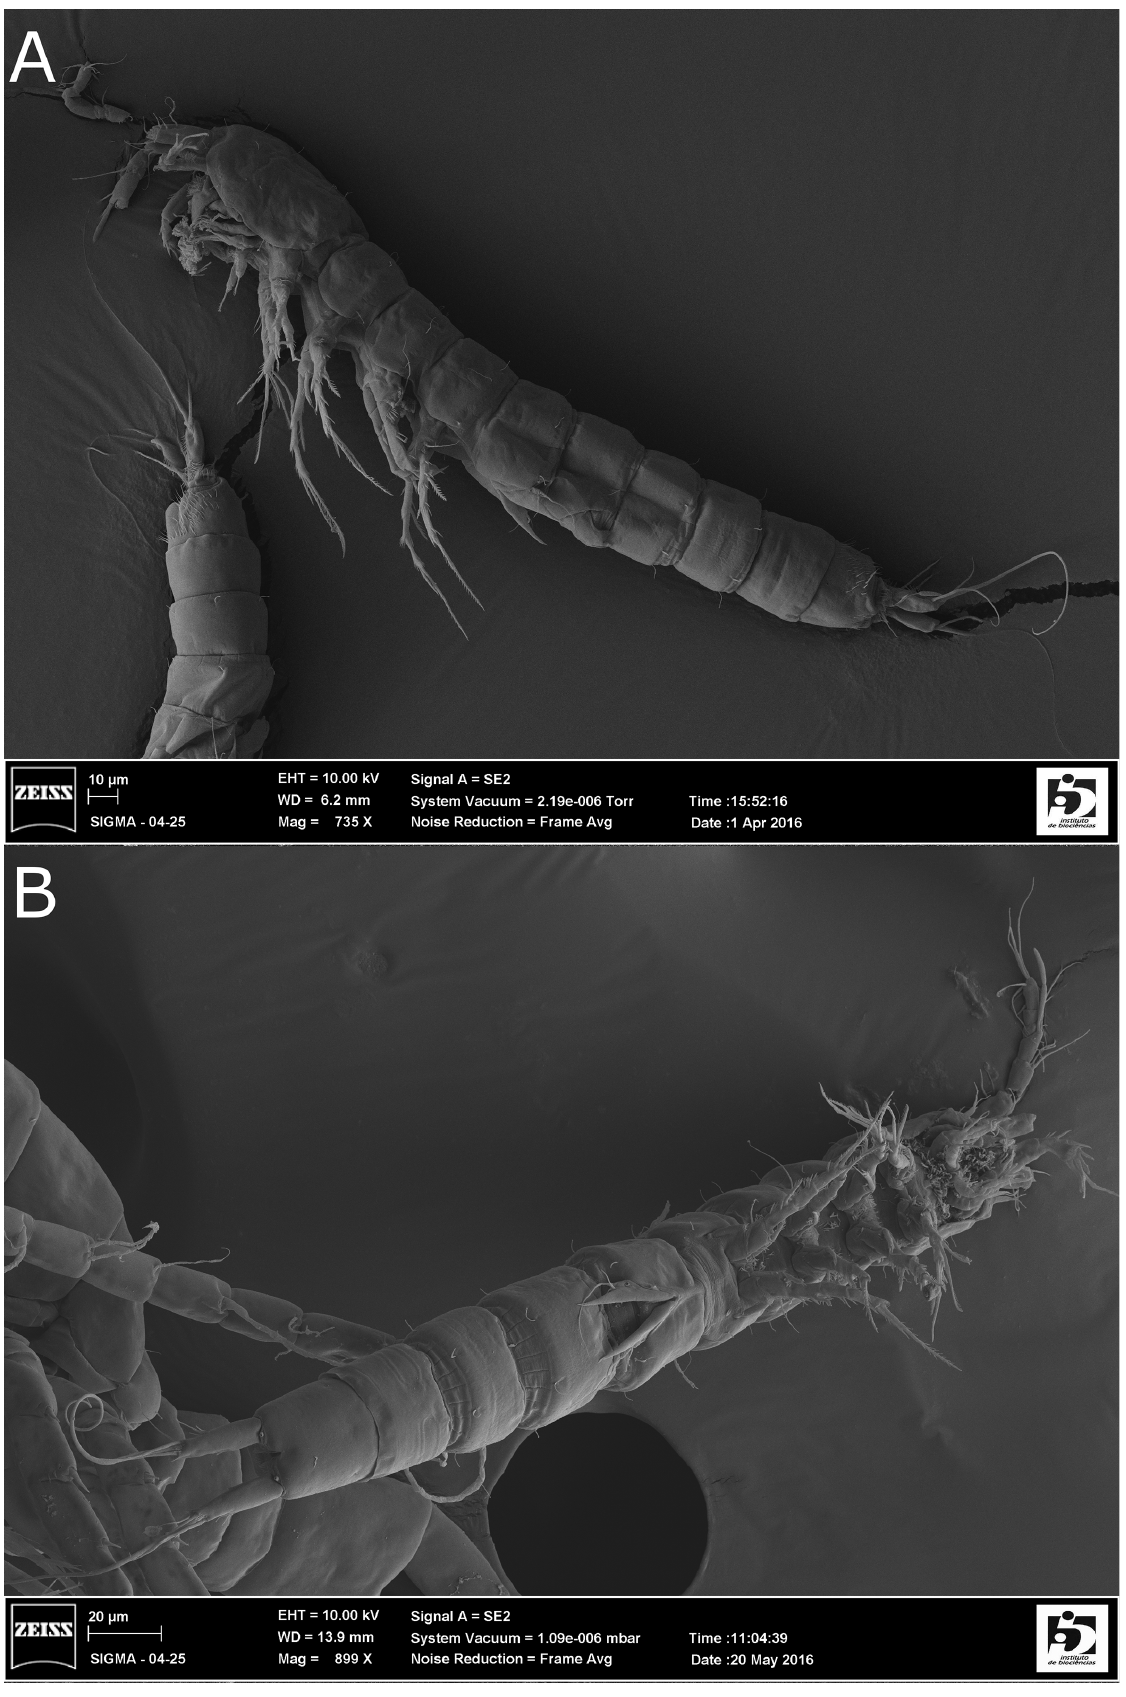
Figure 5. SEM image of Eirinicaris antonioi sp. n. A male habitus, lateral view; B female habitus, ventral view. Scale bar A = 10µm; B =